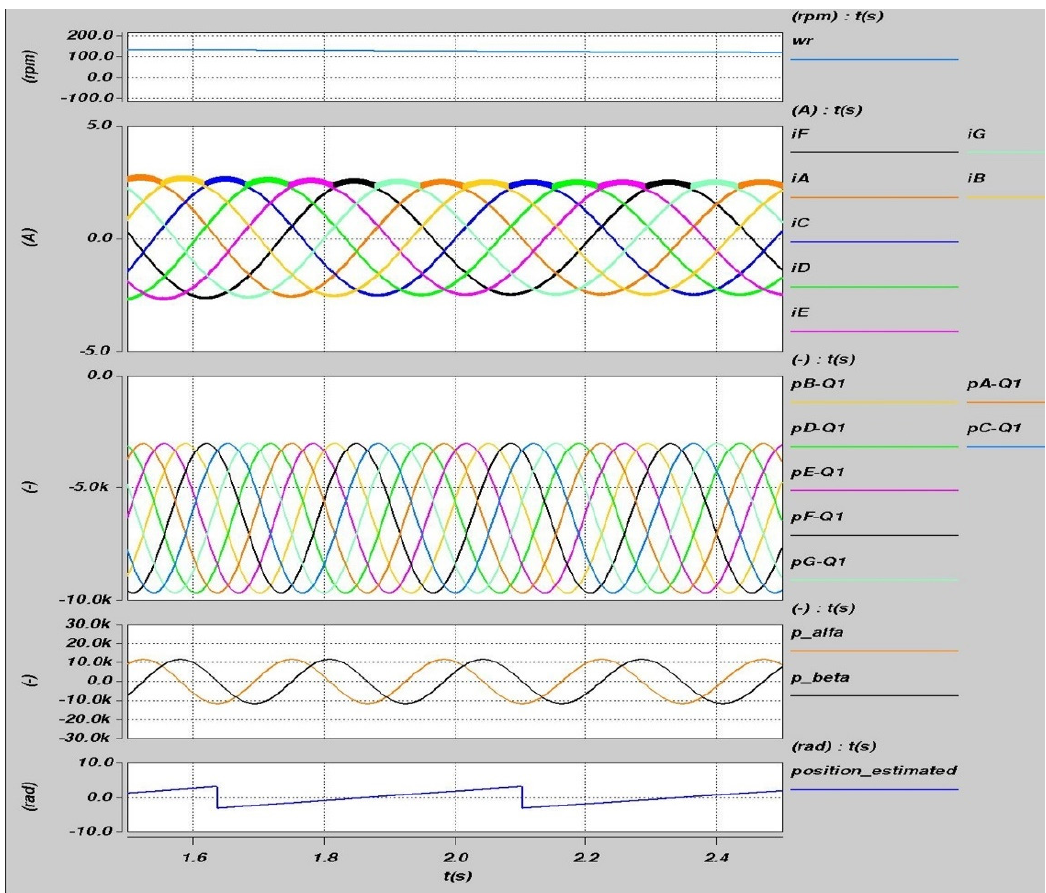
Figure 9. Saliency tracking results using the active vector Q1 (case = 0).